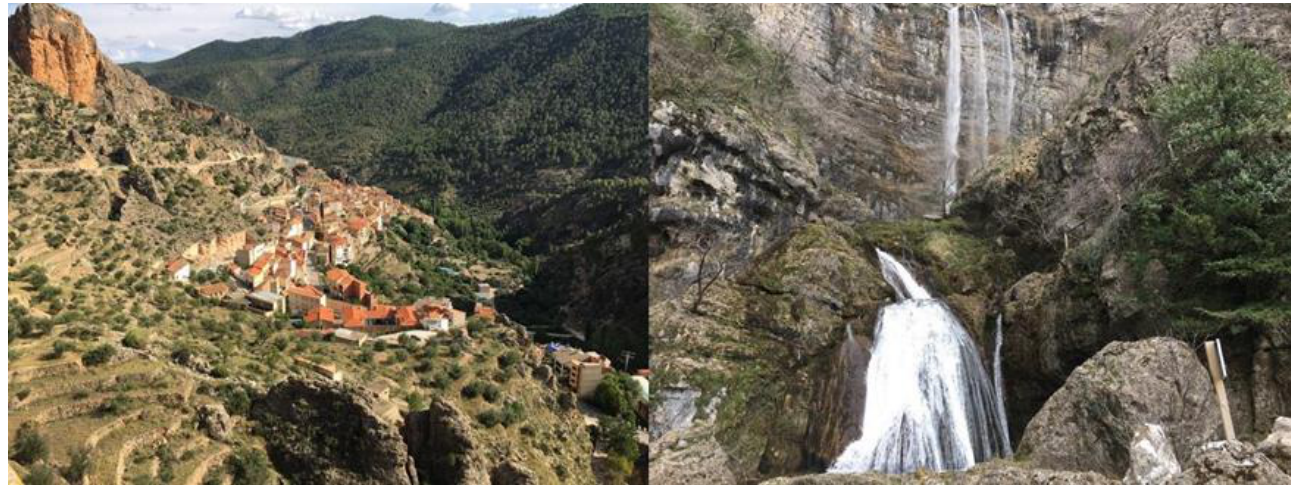
their deterioration (Figure 7). It is necessary to invest in this aspect from the perspectives Figure 6. Rural accommodations, landscape units and hiking trails. Source: Own preparation. Figure 6. Rural accommodations, landscape units and hiking trails. Source: Own preparation. of both landscape education and maintenance.